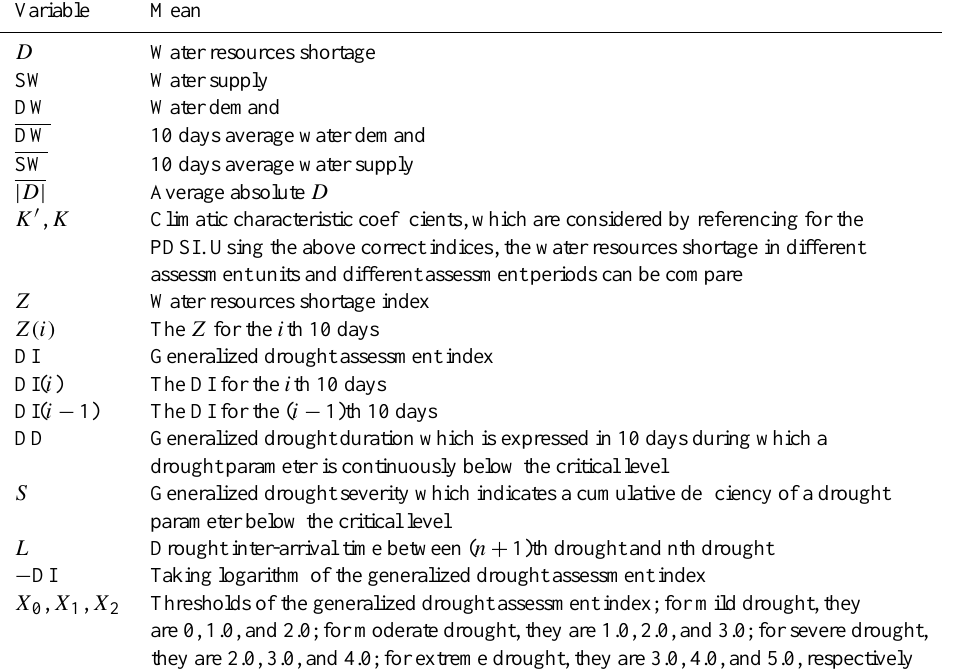
Table A2. All variables used in this